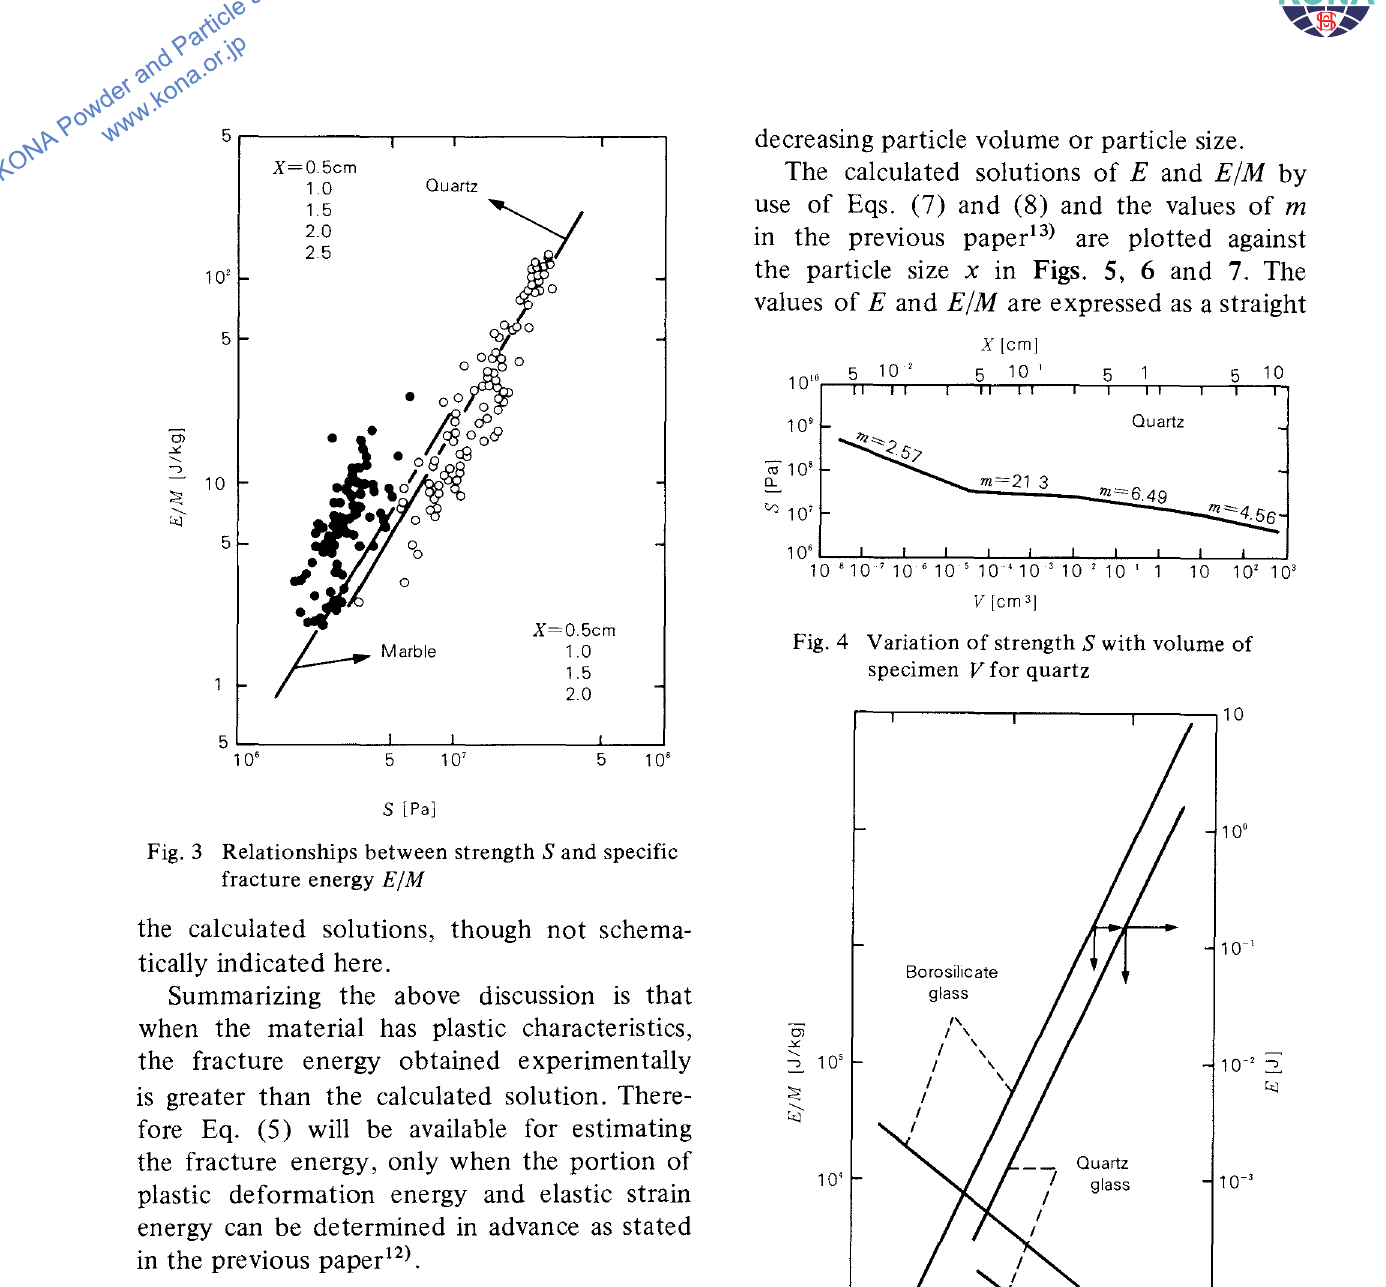
Fig. 5 Relationships between size x and specific fracture energy E/M or fracture energy